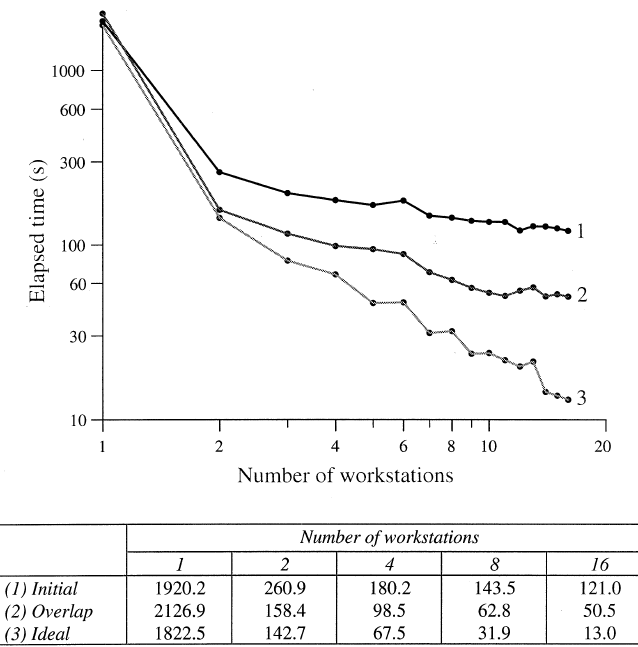
Fig. 7. Reducing idle processor time, by (2) overlapping computation with inter-processor communications, leads to an improved perfor- mance over (1) the initial implementation (for the 1-day model run, using